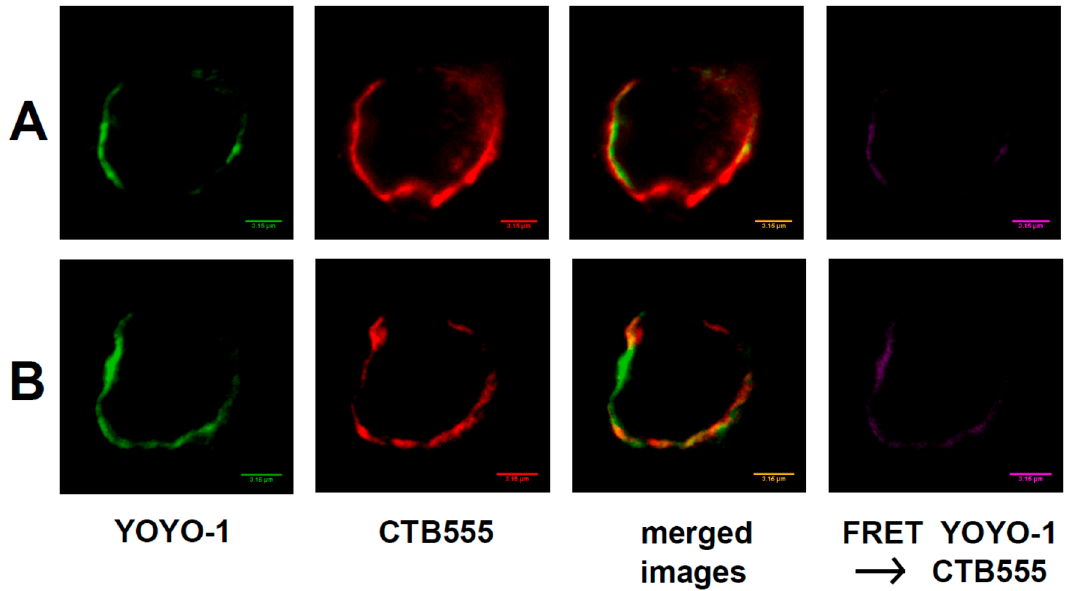
Figure 4. Binding of raft RNA aptamers to lipid raft regions of plasma membrane of neuroblastoma IMR-32 cells by fluorescence and FRET microscopy (representative confocal fluorescent images of IMR-32 cells): green (column I)—YOYO-1 bound to raft RNA aptamers; red (column II)—AlexaFluor-555 conjugated to cholera toxin B (CTB555) bound to the ganglioside GM1 within lipid raft region of the plasma membrane; column III—merged images; column IV—FRET signal. The bars represent 3.15 µ m. ( A , B ) stand for two independent experiments.